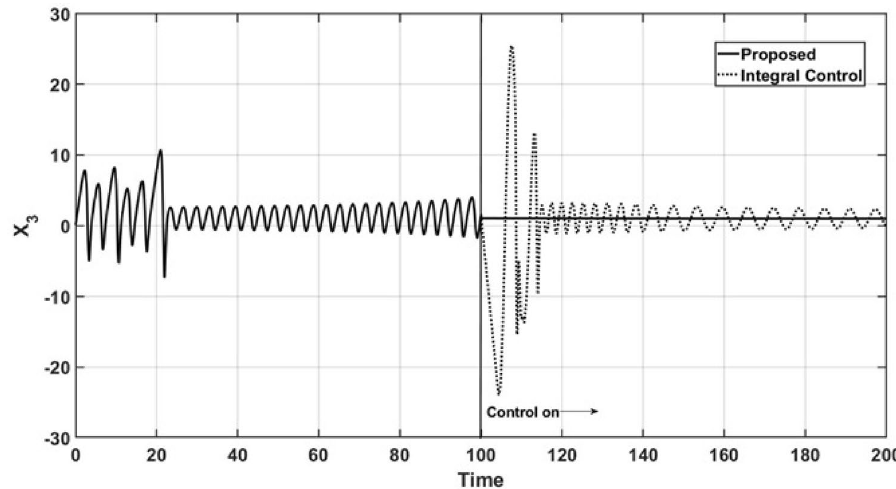
Figure 1. Regulation control of x 3